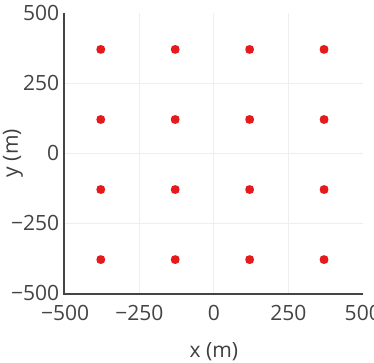
Figure 5. Positions of the 16 sensors considered in the case study, deployed uniformly in the